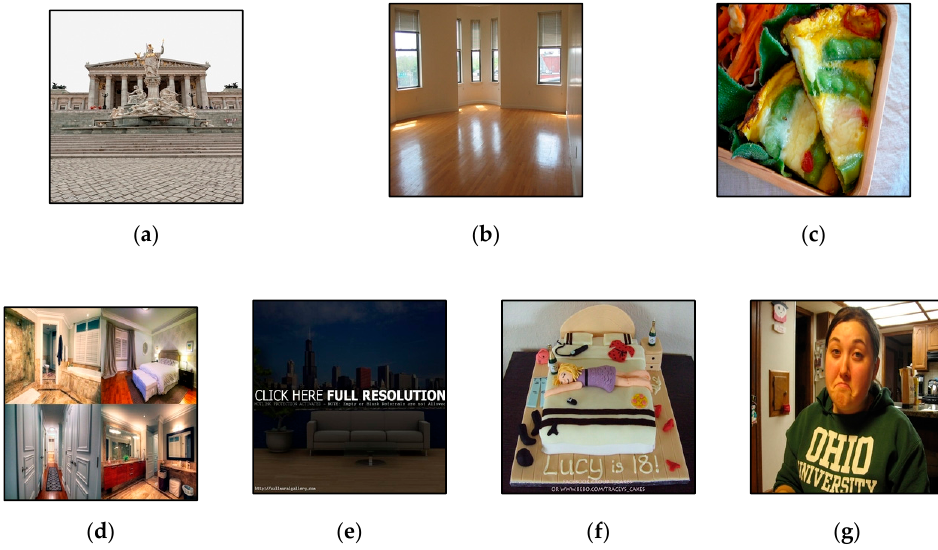
Figure 4. Examples of removed images from room dataset of Places. ( a ) Not belonged to; ( b ) no furniture; ( c ) not wide scene; ( d ) multi-scenes in an image; ( e ) including texts; ( f ) fake scene; ( g ) focusing on people.